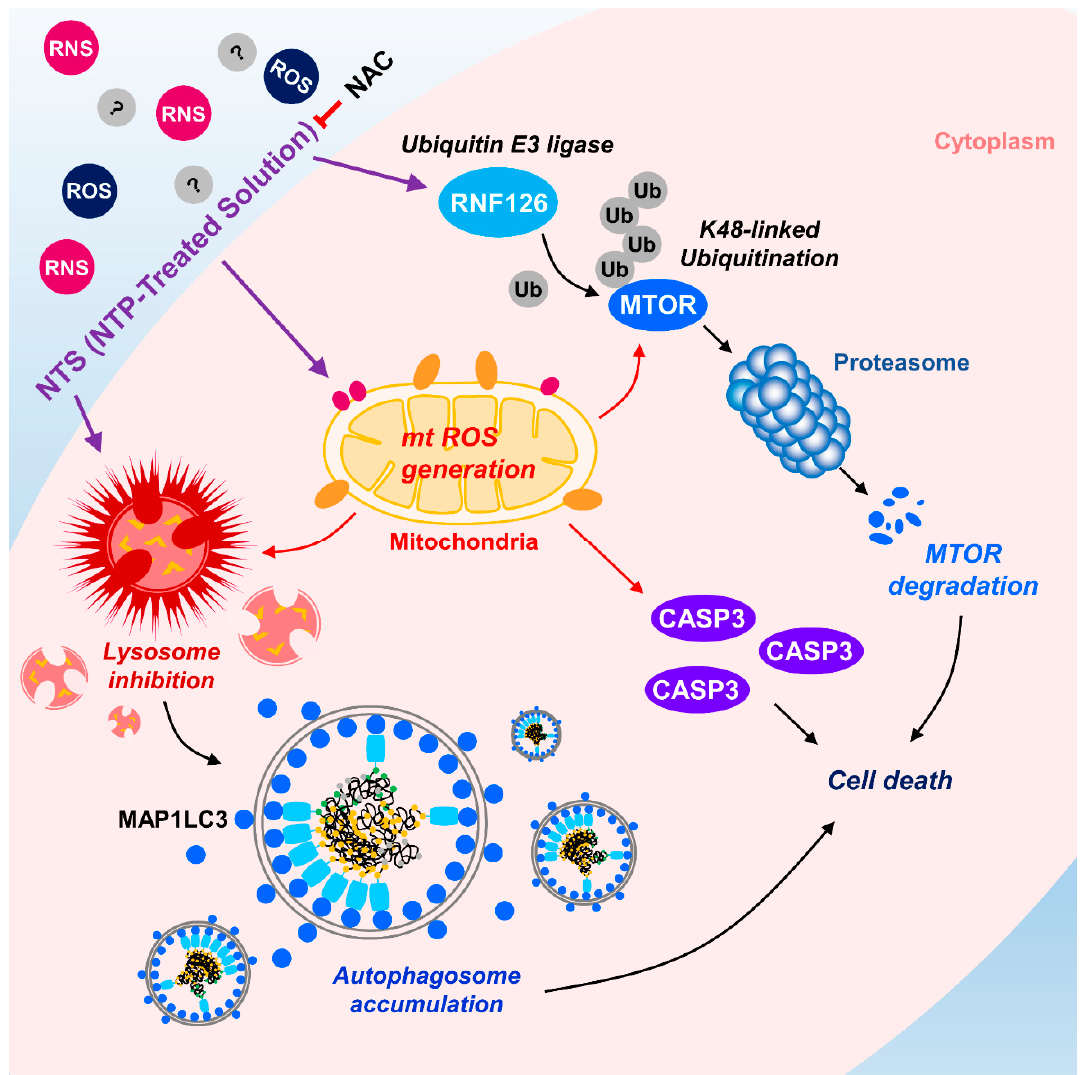
Figure 6. Schematic diagram of RNF126-mediated mTOR ubiquitination in NTS-treated leukemia cells. NTS induces activation of RNF126-mediated mTOR ubiquitination and degradation. NTS-induced mTOR degradation affects lysosomal activity, resulting in accumulation of autophagosomes in cells and subsequent apoptosis. NTS-induced antileukemic effects and/or mTOR ubiquitination are inhibited by antioxidant, NAC.